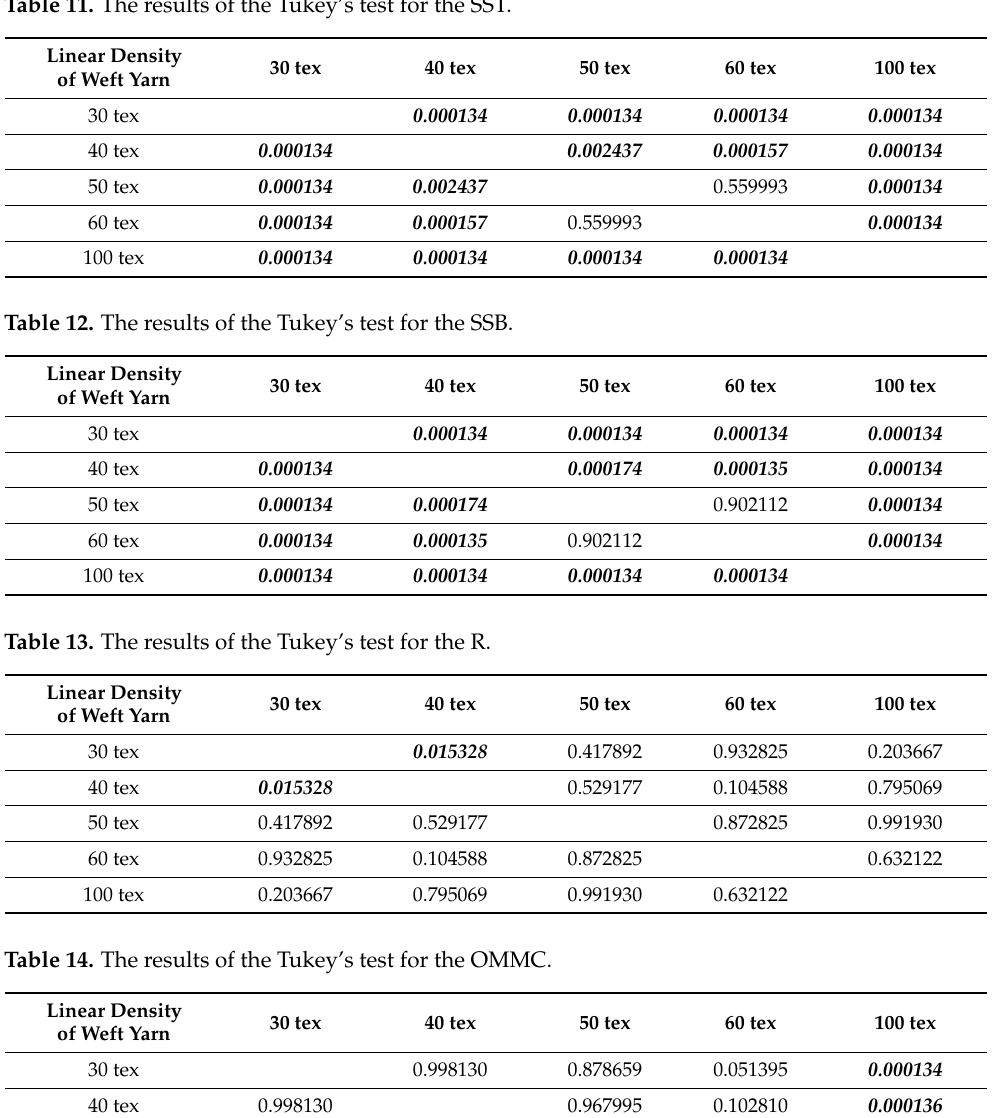
Table 11. The results of the Tukey’s test for the SST.